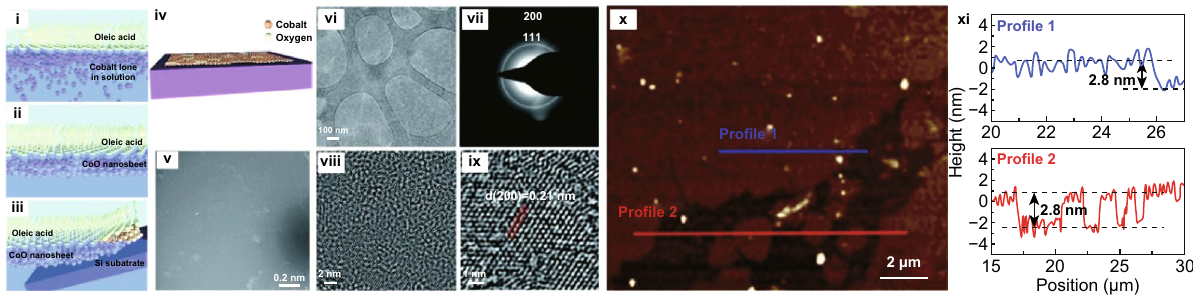
Fig. 9 Large-area synthesis of 2D CoO. Schematic illustration of the processing and formation of CoO nanosheets at the water–air interface ( i – iv ). Co ions crystalise into macroscopic, continuous nanocrystalline CoO nanosheets as large as the water–air interface. ( v ) SEM image cover- ing a Si substrate surface, ( vi ) TEM image, ( vii ) corresponding SAED pattern of a CoO nanosheet. ( viii , ix ) HRTEM images of CoO polycrys- talline nature with an average grain size ~ 3 nm and fully crystallised structure with grain and grain boundaries. ( ix , x ) Typical AFM image and corresponding height profile along the blue and red lines in ( ix ) showing a minimal roughness factor of 0.39 nm and a uniform film thickness of 2.8 nm of CoO nanosheet. Adapted with permission from Ref. [48]. Copyright 2017, Royal Society of Chemistry Publishing Group. (Color figure